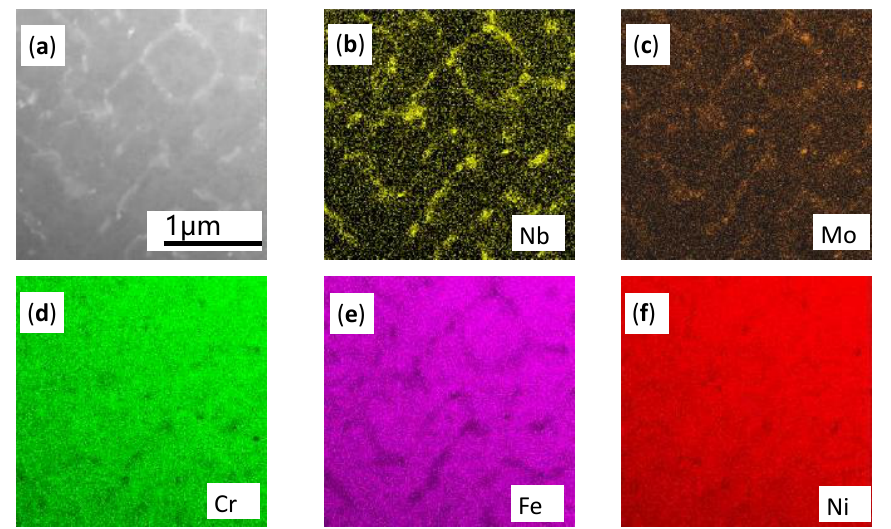
Figure 9. STEM images of the SLM as-built sample in the X-Y plane for compositional analysis. ( a ) Local TEM Morphology; ( b – f ) Distribution of Nb, Mo, Cr, Fe and Ni corresponding to Figure 9a, respectively.